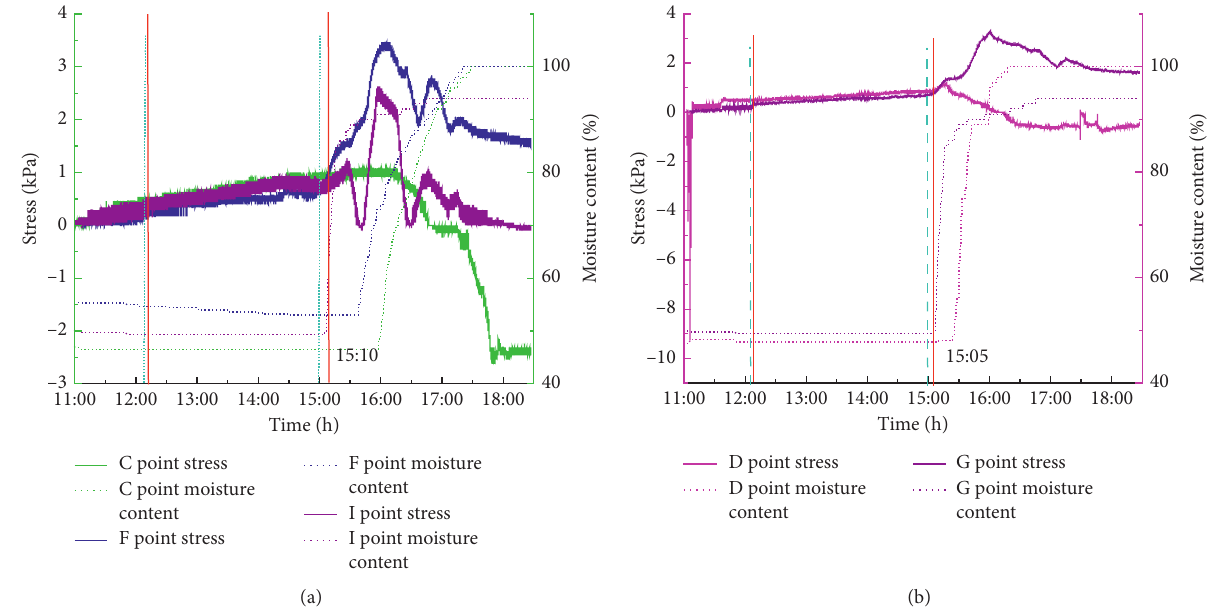
Figure 18: Time history curve of stress-water content in the upper and lower planes of the sliding body. (a) C, F, I measuring point. (b) D, G measuring